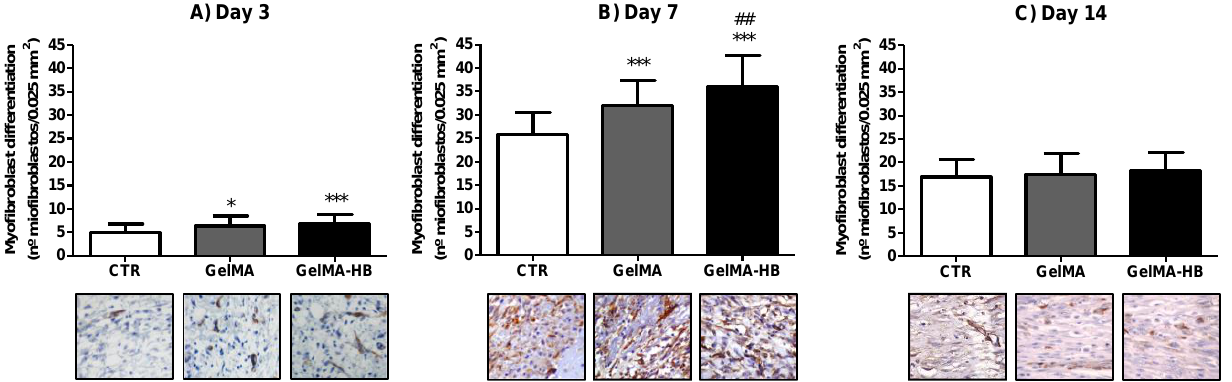
Figure 5. Assessment of myofibroblast differentiation (MFd) over the experimental period (data presented as mean ± standard deviation) on ( A ) day 3, ( B ) day 7 and ( C ) day 14. CTR (untreated control); GelMA (wounds filled with GelMA); GelMA-HB (wounds filled with GelMA containing 2% ethanolic extract of H. bracteatus ). Significant differences compared to CTR are expressed as * p < 0.05 and *** p < 0.001; significant differences in relation to GeLMA are expressed as ## p < 0.01 (ANOVA, followed by Tukey ’ s multiple comparisons test). The photomicrographs at the base of the fi gure constitute histological sections representing the pattern of positive immunostaining for α - SMA in spindle cells in the connective tissue of the scar area in the different groups throughout the experimental period (SABC, 800).